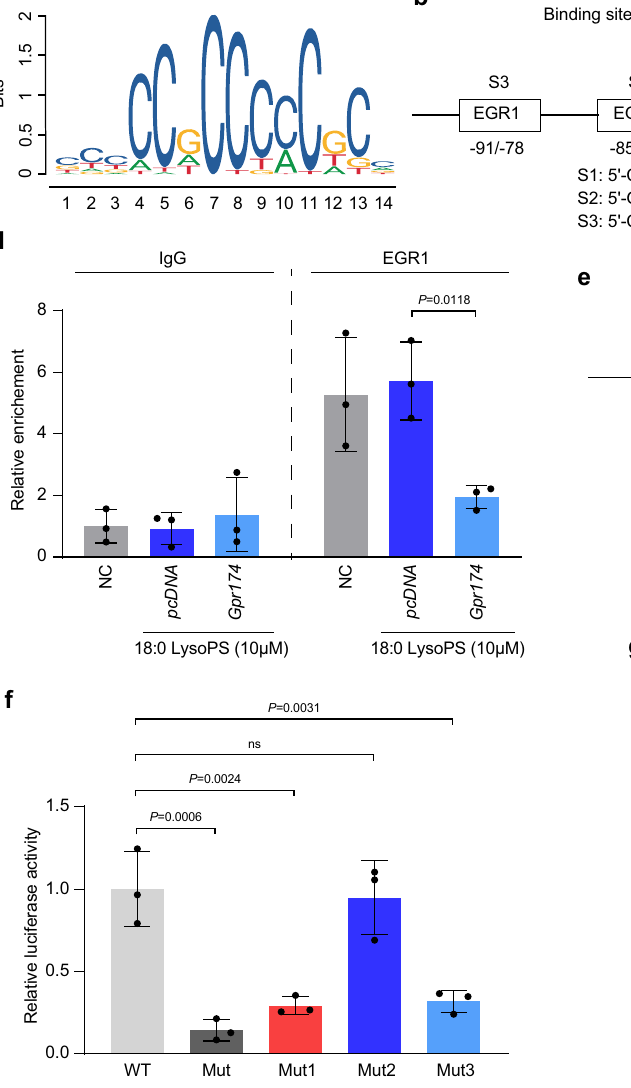
co-transduced with luciferase reporter driven by wild-type or mutated promoter, pRL-CMV-renilla,andexpressionplasmidforEGR1( n =3). g AREGpromoteractivity in HEK293A cells co-transfected with wild-type or mutant 1 Areg promoter con- structs, pRL-CMV-renilla, and Gpr174 CRISPR Activation Plasmid or treated with H 89 2HCL ( n =3). For all statistical plots, the data are presented as mean±SD. Two- tailed unpaired t-tests in ( c ). Two-way ANOVA with Bonferroni multiple compar- isons test in ( d , f , g ). Source data are provided as a Source Data fi